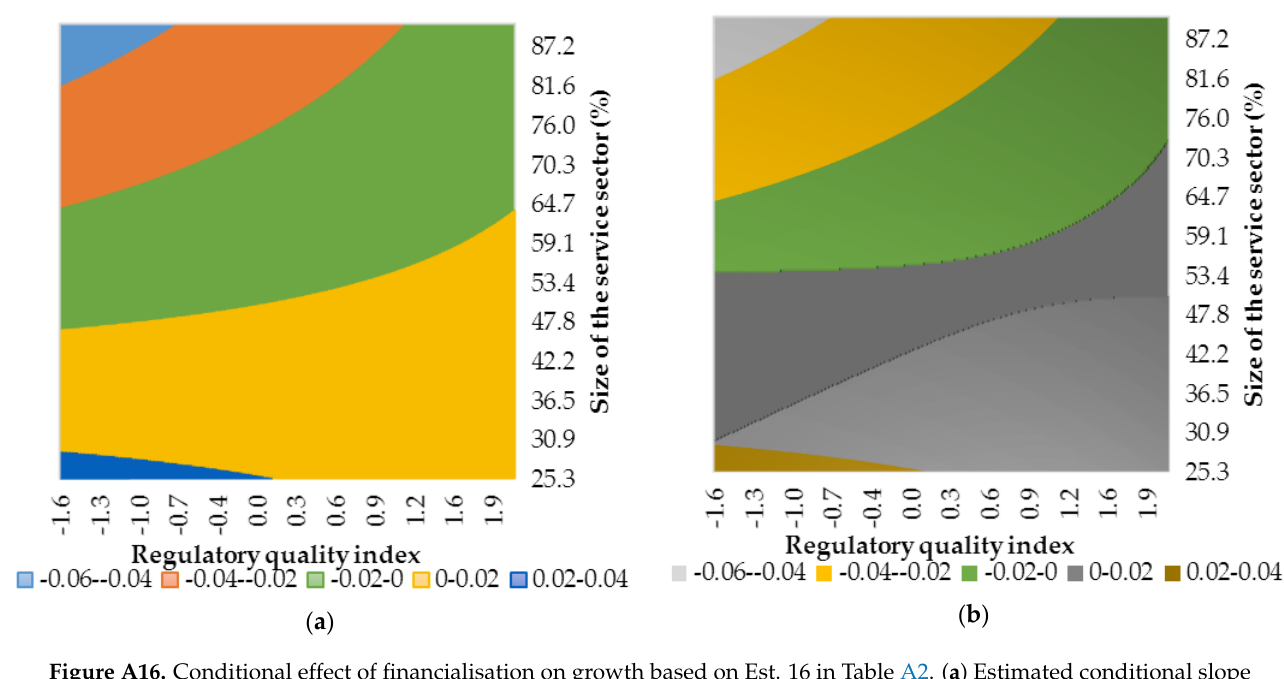
Figure A16. Conditional effect of financialisation on growth based on Est. 16 in Table A2. ( a ) Estimated conditional slope coefficient over the whole range of observed values for institutional quality and development level. ( b ) Estimated statistically significant conditional slope coefficient. Dark gray represents a combination of institutional quality and development level for which effect of financialisation on growth is statistically insignificant. Source: authors’ contributions.